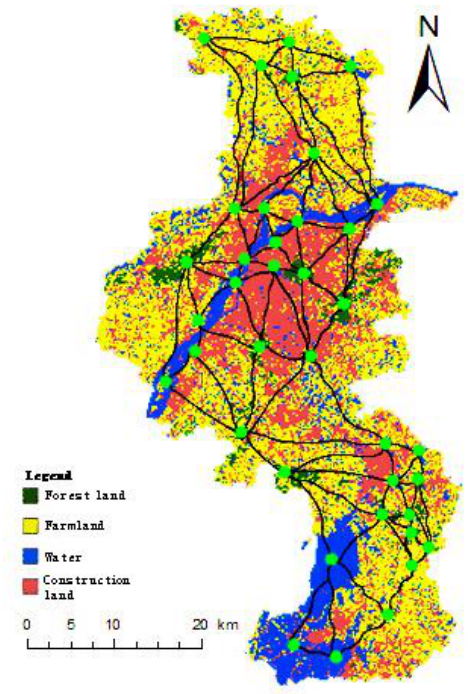
Figure 6. Least-cost ecological network of